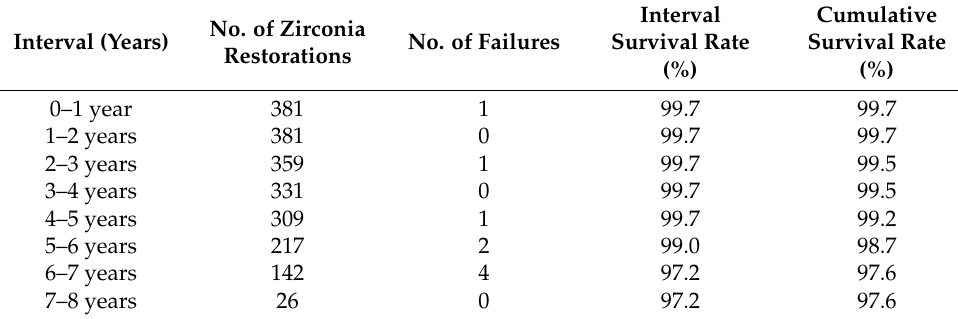
Table 3. Life table analysis of zirconia restoration